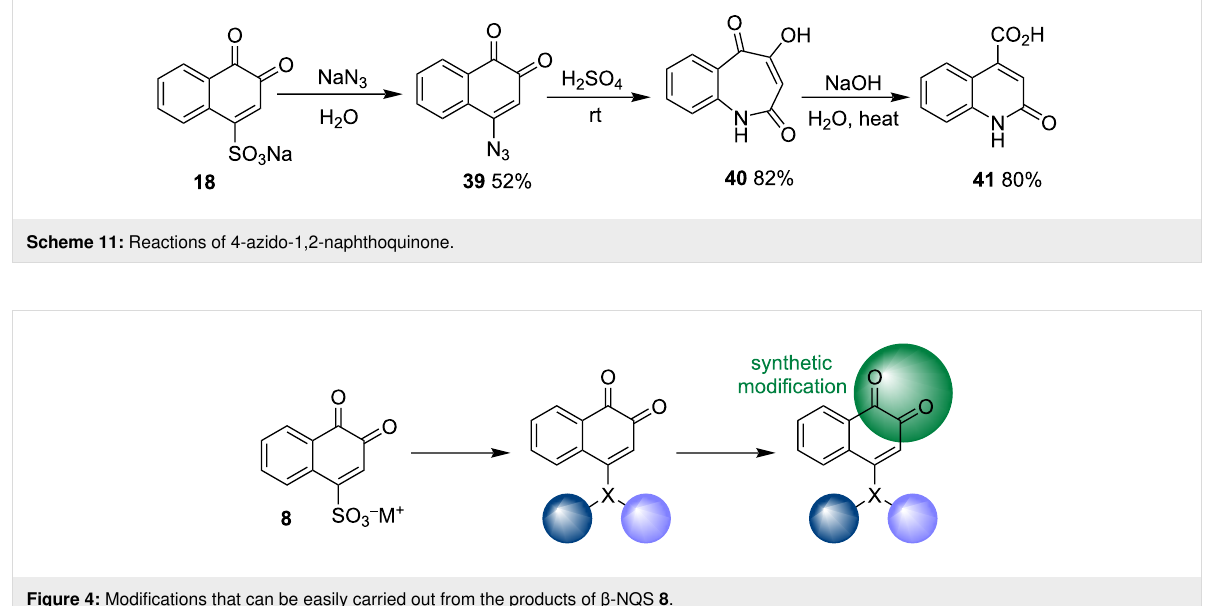
was reacted with different amines 42a–c in the presence of an ethanol–water mixture under ultrasonication, followed by reac- tion with arylhydrazines , which led to hydrazones 44a–l accord- ing to the classical procedure that employs methanol at room temperature. All compounds were evaluated against different human cancer cell lines, including leukemia (HL-60), melanoma (MDA-MB-435), colon cancer (HCT-116), and central nervous system cancer (SF-295). 4-Amino-1,2-naphtho- quinones 43a–c exhibited considerable cytotoxic activities, with 43a being the most active against HL-60 and MDA-MB-435 cells (Scheme